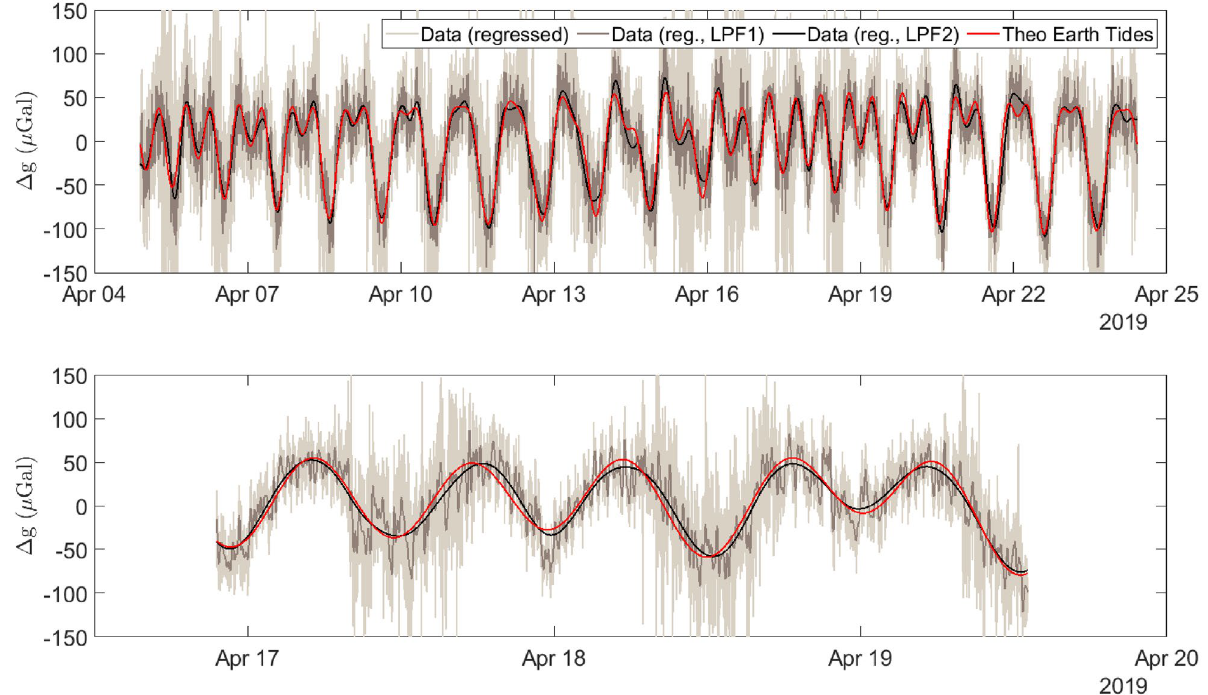
Figure 2. Two time series plots of the Earth tide measurement, conducted at the University of Glasgow in April 2019. In both graphs, the red series is a theoretical signal calculated using T-Soft, the gray-scale series are the experimental data recorded using the MEMS gravimeter. From lightest grey to black, these series represent increasing filtering of the data using a low-pass filter. The black series was filtered with a 20 µ Hz bandwidth low-pass filter. All of the theoretical data is presented after a regression analysis was used to remove drifts caused by temperature variations within the system. The upper graph shows the full data set, the lower graph shows a zoomed in selection of this data.